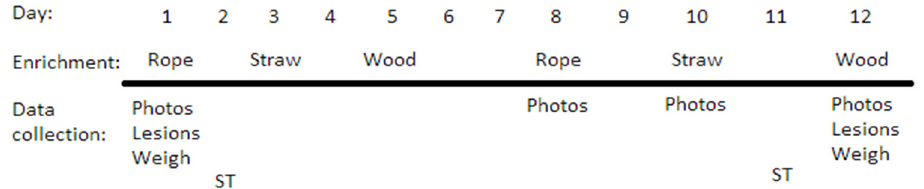
Figure 3. Timeline illustrating data collection and the rotation schedule for enrichments in Rotation and Stimulus treatments. Each treatment lasted 12 days, followed by two days off. Four treatments were provided consecutively to each pen group ( n = 6) in random order over a period of eight weeks (beginning at 5–6 weeks and ending at 13–14 weeks of gestation).